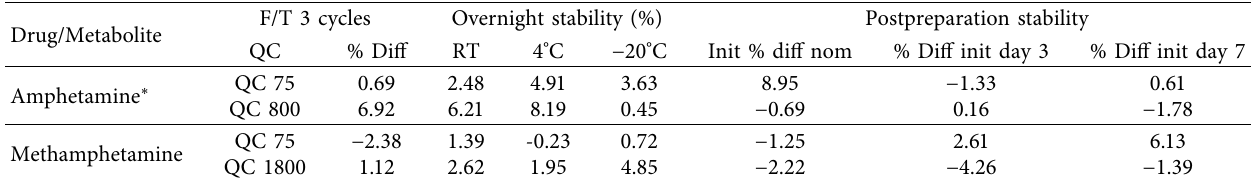
Table 8: Stability testing. QC samples were tested for stability after 3 freeze-thaw cycles. Tey were also tested overnight at the indicated temperatures. A 3- and 7- day postextraction study were also performed at 2–8 ° C.